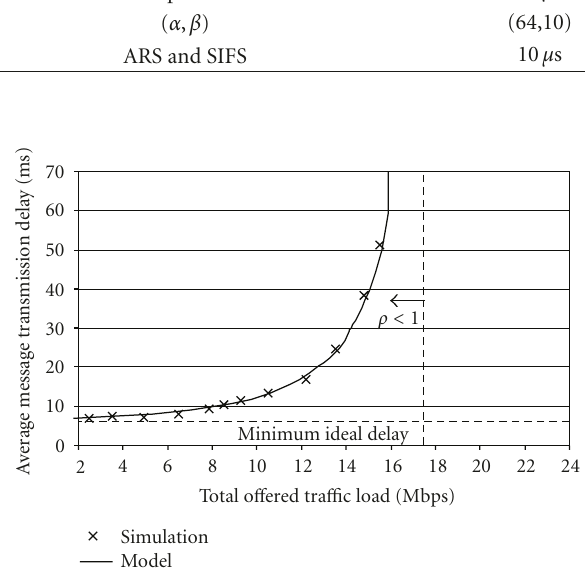
Figure 11: Average Message Transmission Delay (Model versus